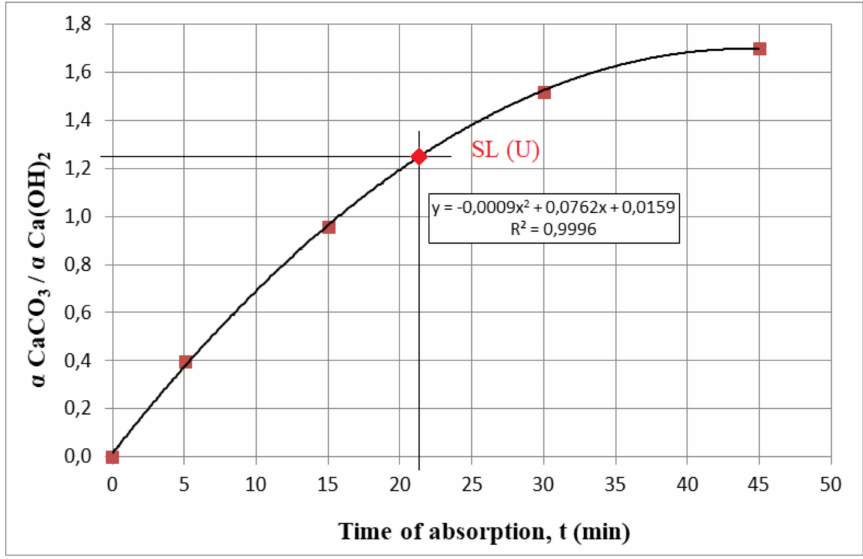
Figure 8. Relationship between calcium carbonate amount and calcium hydroxide amount ratio and